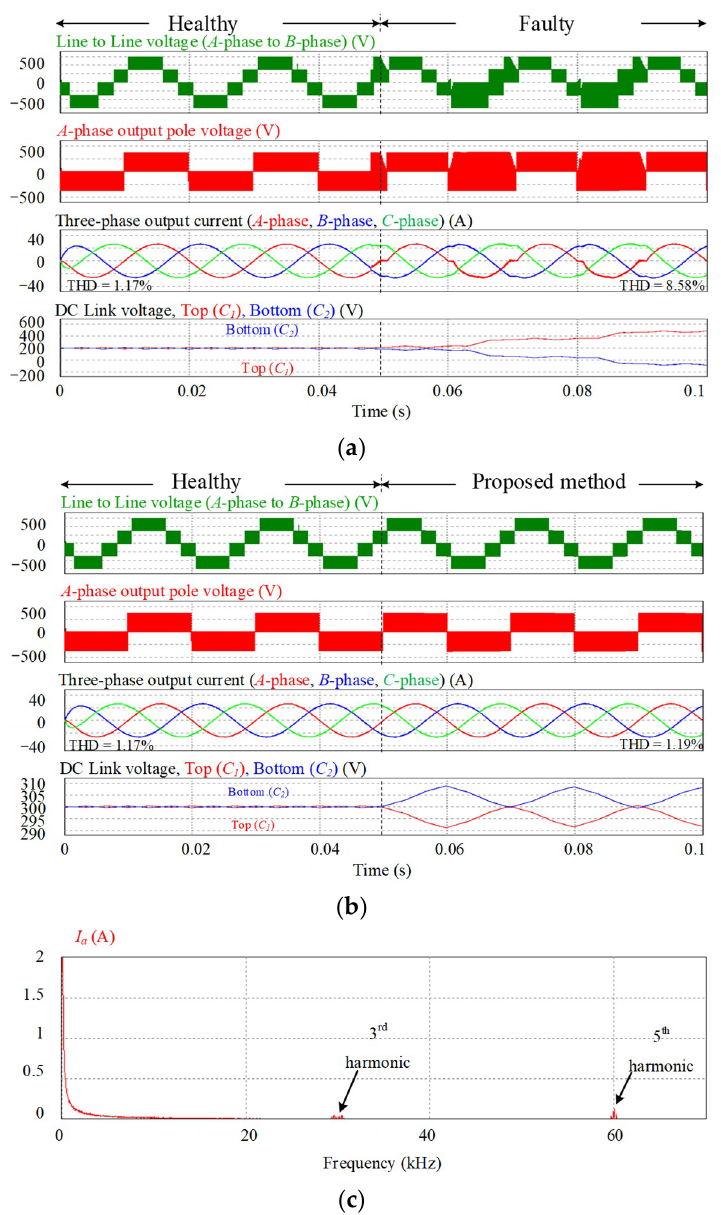
Figure 9. V ab , V an , three-phase currents, and DC link voltages when an open-circuit failure occurs at S a2 / D a 2 healthy and faulty conditions ( a ) before applying the proposed method, and ( b ) after applying the proposed method. ( c ) The corresponding harmonic distribution after applying the proposed method.